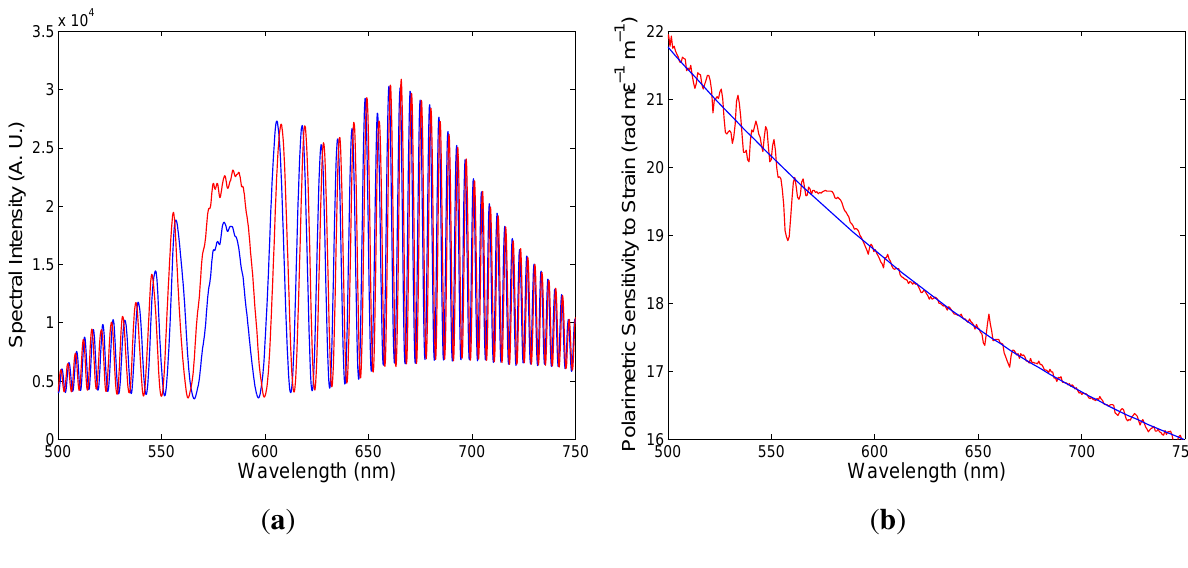
Figure 5. Examples of the recorded spectra corresponding to two elongations, ∆ L = 100 (cid:22) m (blue) and ∆ L = 150 (cid:22) m (red), of the FUT ( a ). The spectral dependence 1 2 of the absolute value of the polarimetric sensitivity to strain ( b ). The line is the approximate quadratic dependence.